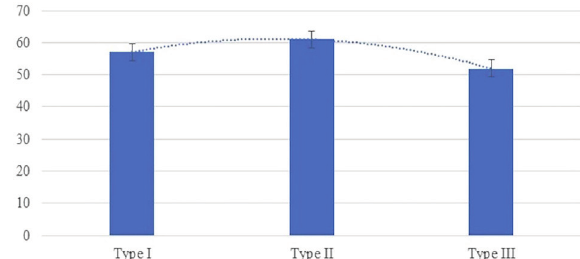
Figure 4 - Patient age distribution by aortic dissection types